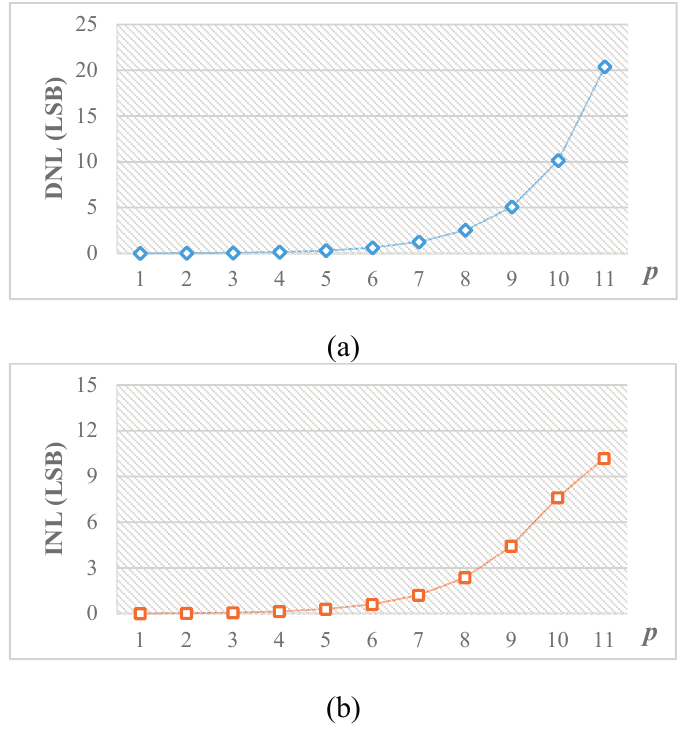
Figure 10. Behavior simulation results of ( a ) DNL and ( b ) INL vs. p .